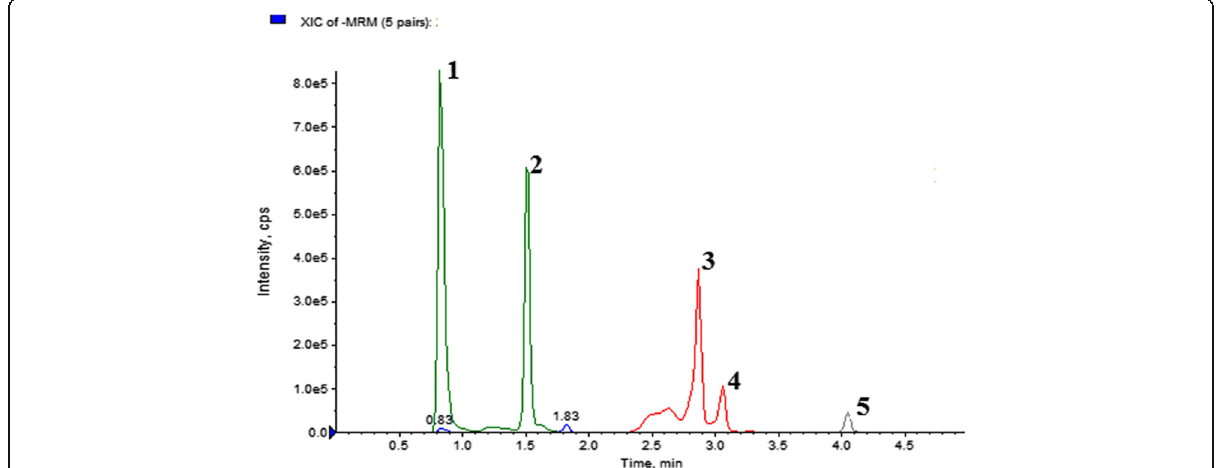
Fig. 5 MRM extracted chromatogram of standards bioactive compounds mixture obtained by UPLC-ESI – MS/MS in negative mode